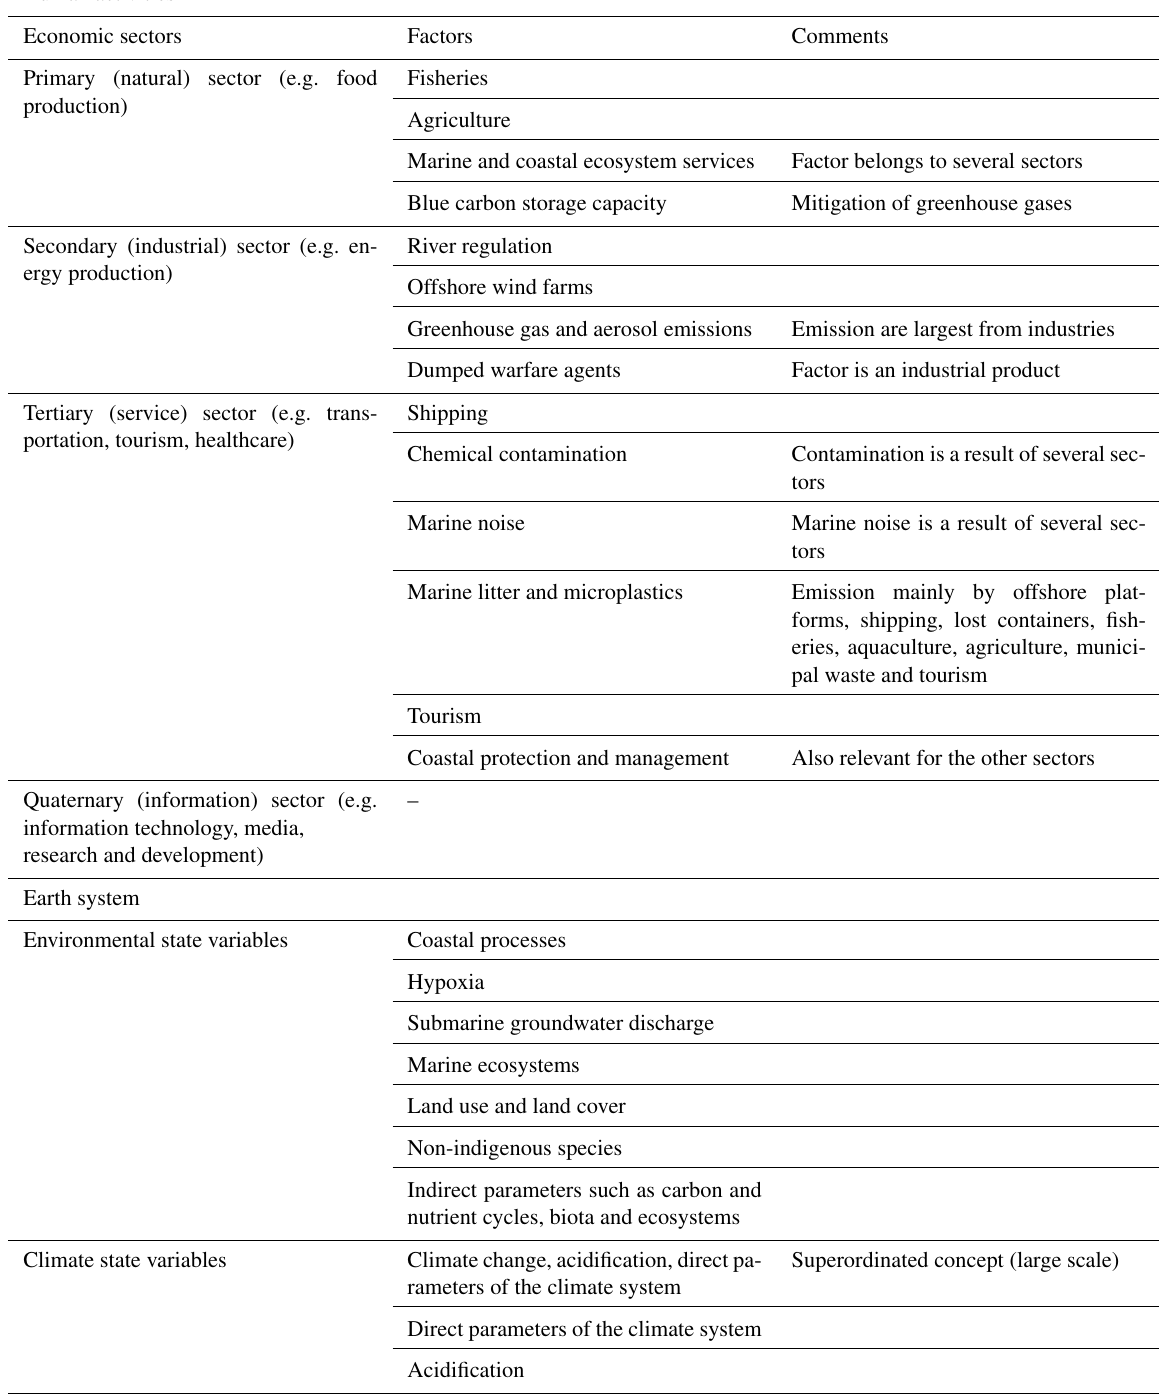
Table 3. Factors discussed by Reckermann et al. (2022) sorted by related economic sectors or state variables of the Earth